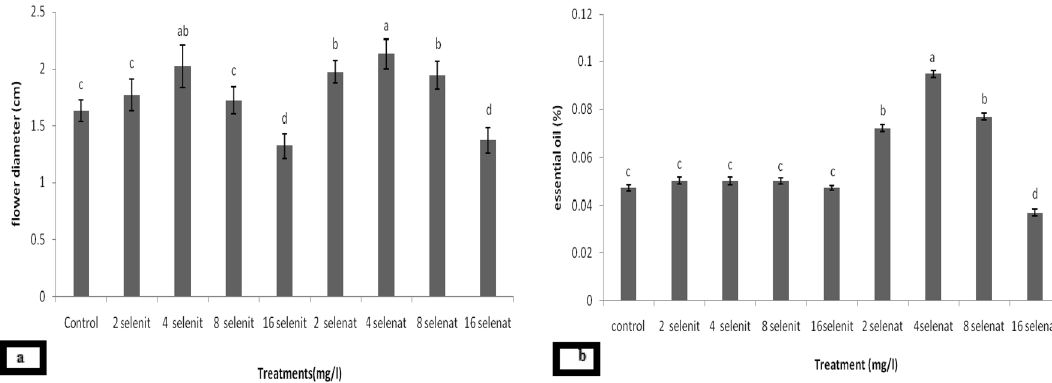
Figure 2. The effect of selenium sources in full flowering stages on flower diameter (cm) ( a ) and essential oil (%) ( b ) of Echium amoenum . Different capital letters at the same specie indicate differences between treatment according to the Duncan ʼ